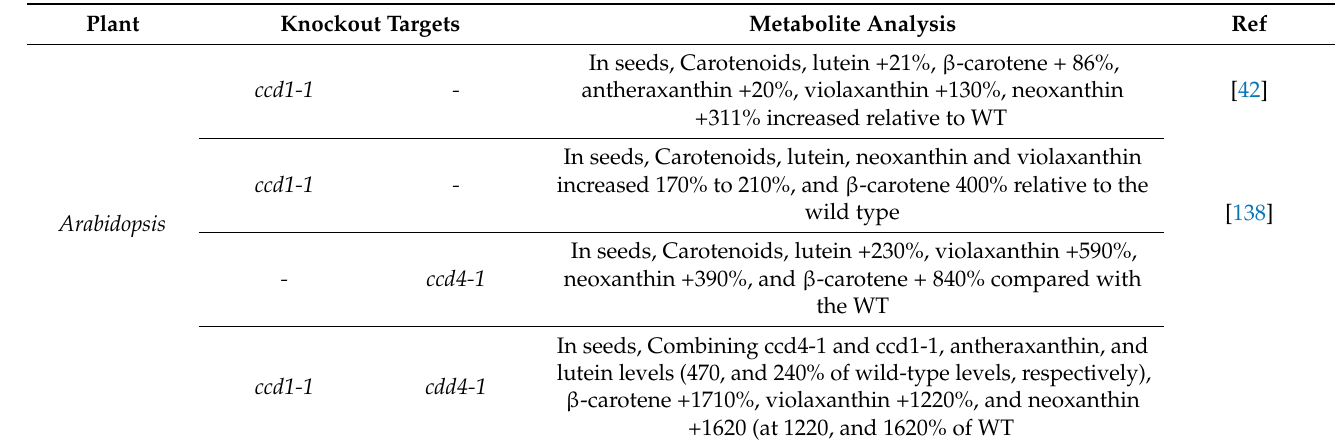
Table 3. Summary of the impacts of preventing carotenoid cleavage by